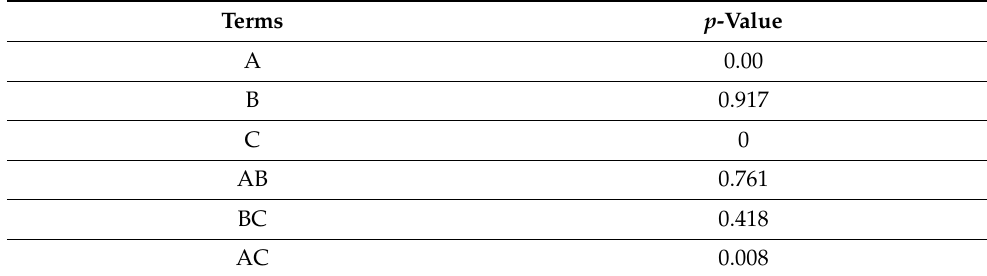
Figure 16. Effects of temperature and soaking time on hardness, computed using Minitab software. Table 4. The p -values for different parameters and interactions. Terms